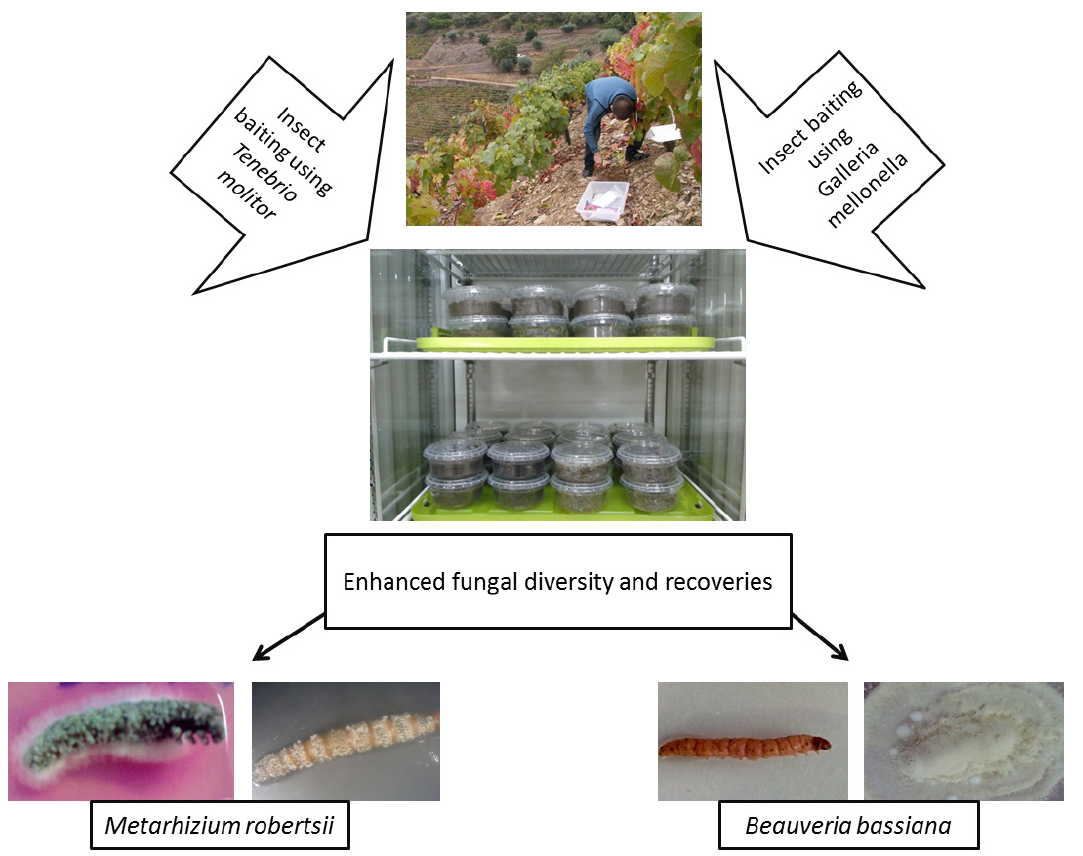
Figure 2. Isolation of entomopathogenic fungi from soils using the “ Galleria - Tenebrio -bait method” The method has been described in detail by Sharma et al. [7].